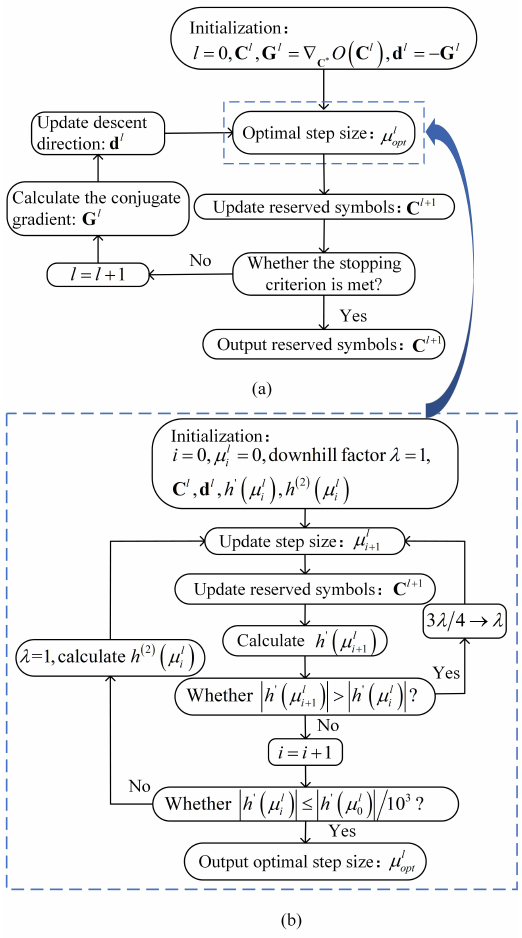
Figure 2. Flow chart of the overall algorithm and the step size optimization, ( a ) overall algorithm. ( b ) step size